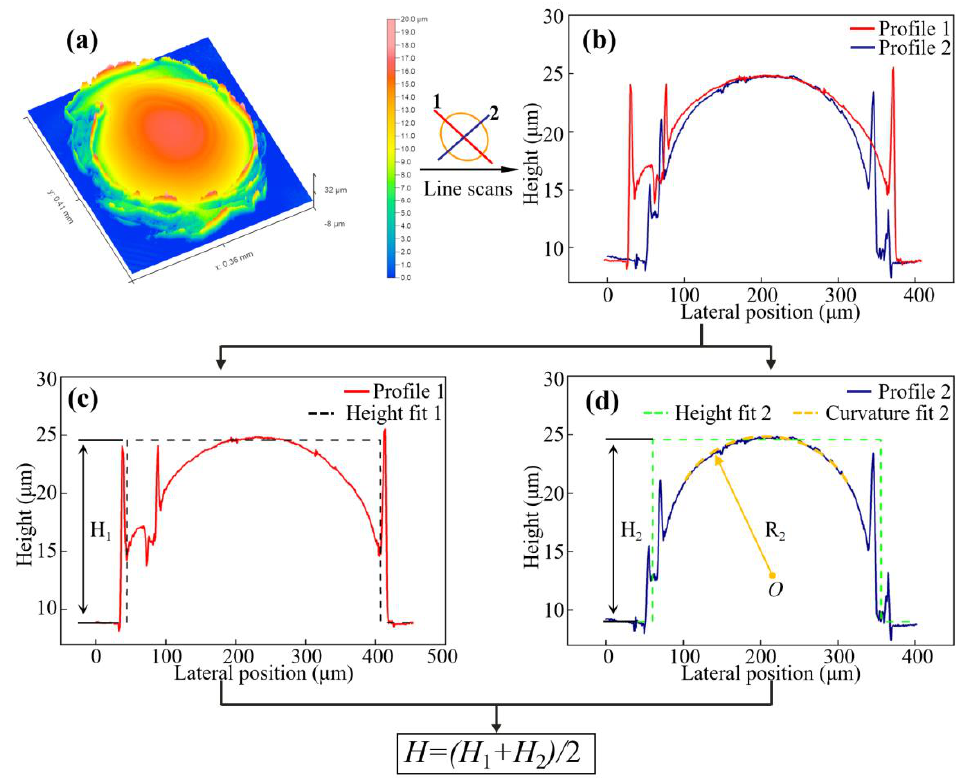
Figure 5. Quantification method of filling capacity. ( a ) Surface topography of microlens on em- bossed glass, ( b ) surface profiles extracted from the surface topography of microlens, ( c ) fitting of profile 1, ( d ) fitting of profile 2. ( d ) fitting of profile